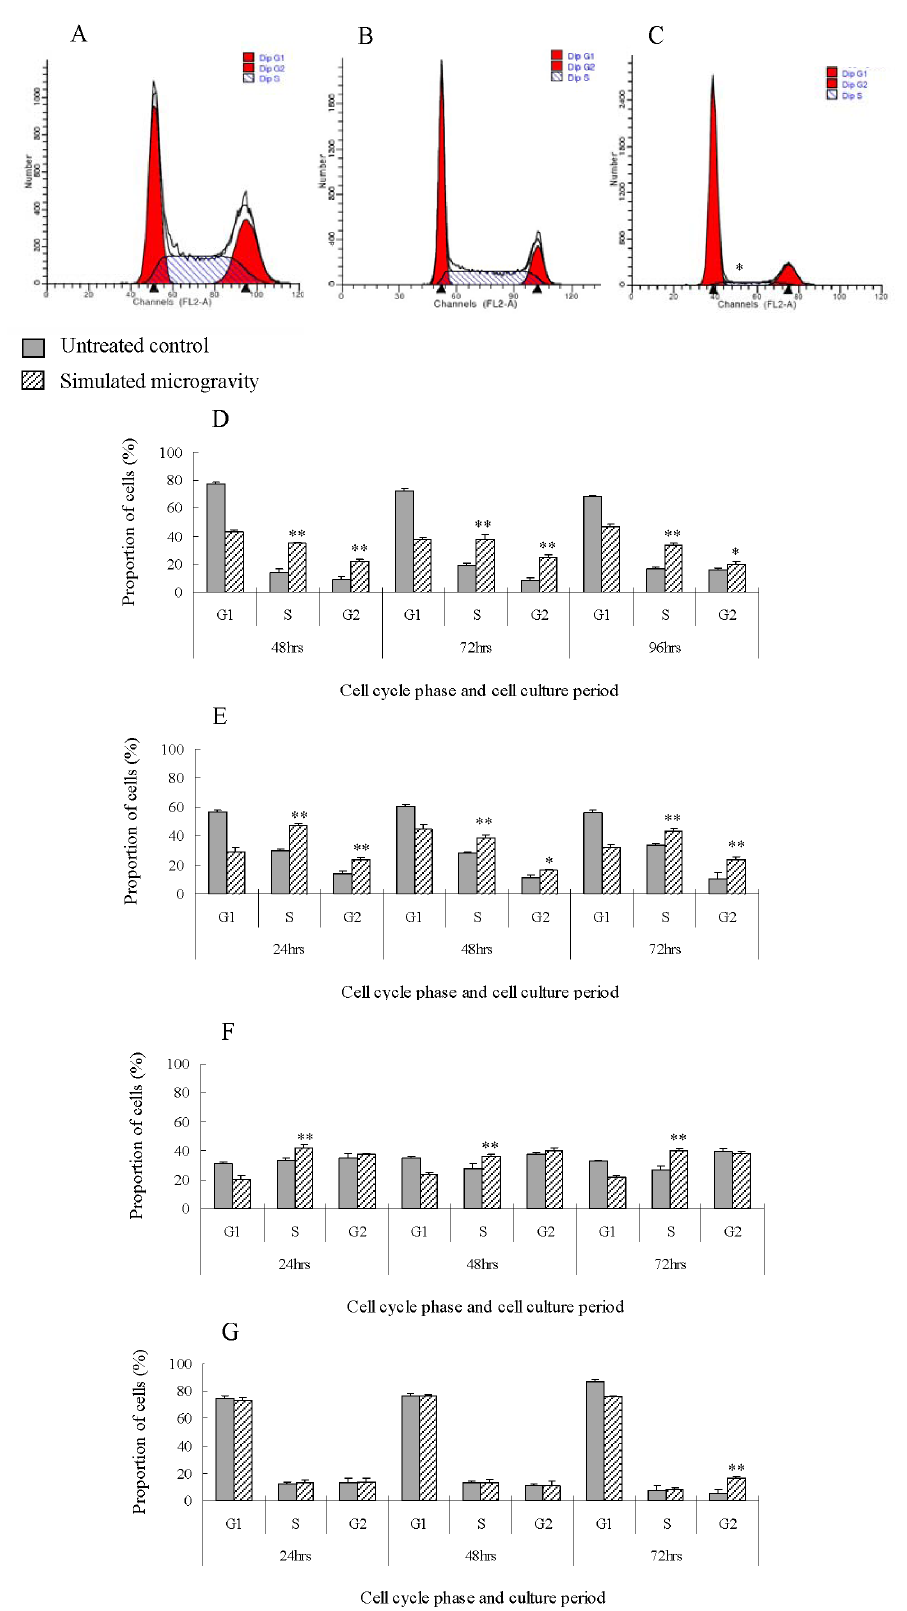
Figure 3. Results of cell cycle analysis. Cell-cycle histograms of MG-63(A), U-2 OS (B) cells and rat calvaria primary osteoblast(C) under simulated microgravity for 72 hours. The cycle changes of MG-63(D), U-2 OS(E), hFOB1.19(F) cells and rat calvaria primary osteoblast(G) under simulated